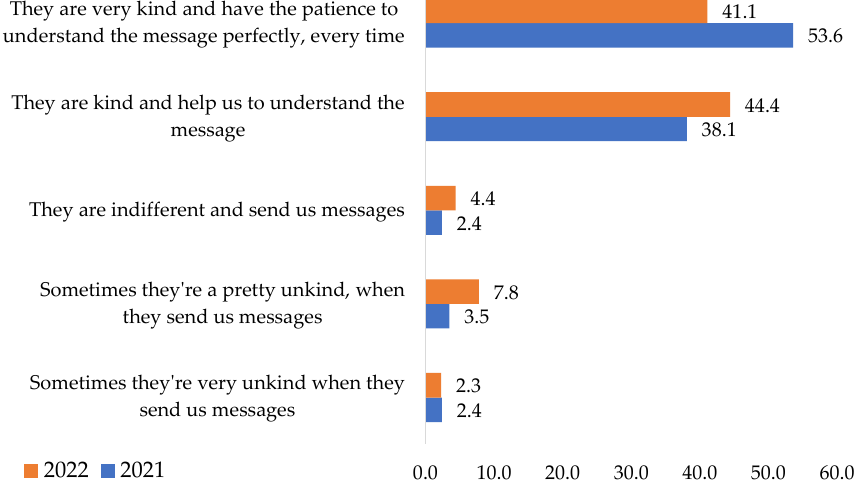
Figure 11. Communication with subordinates during the pandemic: Data from field quizzes, 2021, 2022. The staff considered that they connected very well using the most appropriate telematic means for each employee in proportion to the affirmative answers of 32.1% in 2021 and 52.4% in 2022, followed by those who considered that they communicated well. Still, they involved more time explaining the tasks to be performed in the proportion of 22.6% in 2021 and 33.3% in 2022. Applying the chi-square test confirms the association of the variables. It results from the correlation of the employees’ answers with the staff that the last ones performed more intense activity during the considered period. The team effort had a positive appreciation of employees regarding communication and a good understanding of tasks to be accom- plished. Therefore, hypothesis H6 is confirmed.